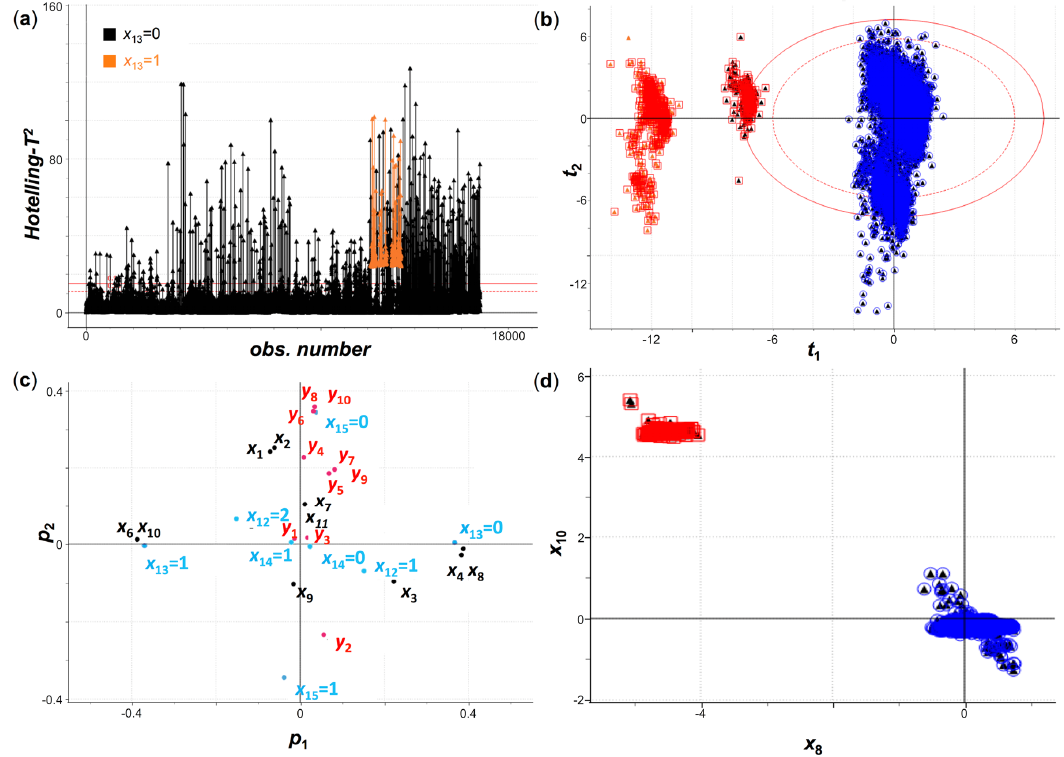
Figure 7. ( a ) Hotelling- T 2 plot of the observations in the dataset with the summary variables and CQCs for a PCA model fitted with five LVs [R 2 (X) = 76%], T 2 95% (dotted red line) and 99% (continuous red line) confidence limits, colored by x 13 (black: 0; orange: 1); ( b ) scores plot for the two first LVs ( t 2 vs. t 1 ) showing three clusters of observations: red circled orange dots associated to x 13 = 1, above average values for x 6 and x 10 and below average values for x 4 and x 8 ; red circled black dots associated to x 13 = 0, above average values for x 6 and x 10 and below average values for x 4 and x 8 , and; blue circled black dots associated to x 13 = 0, below average values for x 6 and x 10 and above average values for x 4 and x 8 ; ( c ) loadings plot for the two first LVs ( p 2 vs. p 1 ) with CQCs in red, continuous process variables in black, and binary process variables in cyan; ( d ) scatterplot for x 10 vs. x 8 , using the same color code as in Figure 7b.